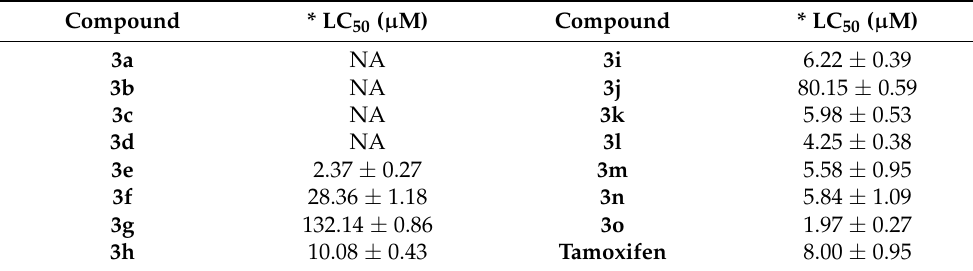
Figure 5. Compound 3a potently induces apoptosis in breast cancer MCF-7 cells (Annexin V/PI Fluorescence-activated cell sorting (FACS)). ( A ) Flow cytometry analysis of the effect of compound 3a on MCF-7 cells. The MCF-7 cells were treated with 2 µ M of compound 3a for 48 h, and then collected and processed for analysis. ( B ) The quantitative analysis of the apoptosis. The values represent the mean ± SEM (Standard error of means) for three independent experiments. The statistical analysis was performed using a one-way ANOVA-Bonferroni post-hoc test (**, p < 0.01). The four quadrants are identified as follows: lower left (LL), viable; Lower right (LR), early apoptotic; Upper right (UR), late apoptotic; and Upper left (UL), necrotic. Table 2. Mortality response of zebrafish embryos to exposure to 3a–o